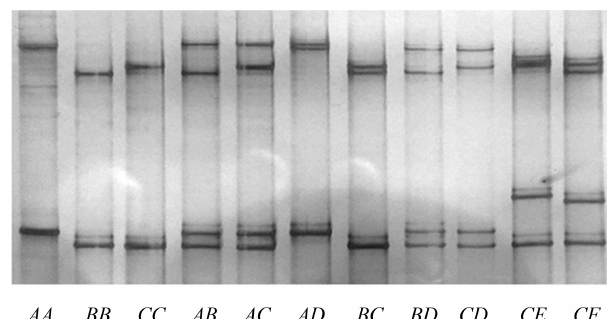
Figure 2. PCR-SSCP of caprine KRTAP15-1 . Six unique SSCP banding patterns, corresponding to six different variant sequences (A to F) are shown in either homozygous or heterozygous